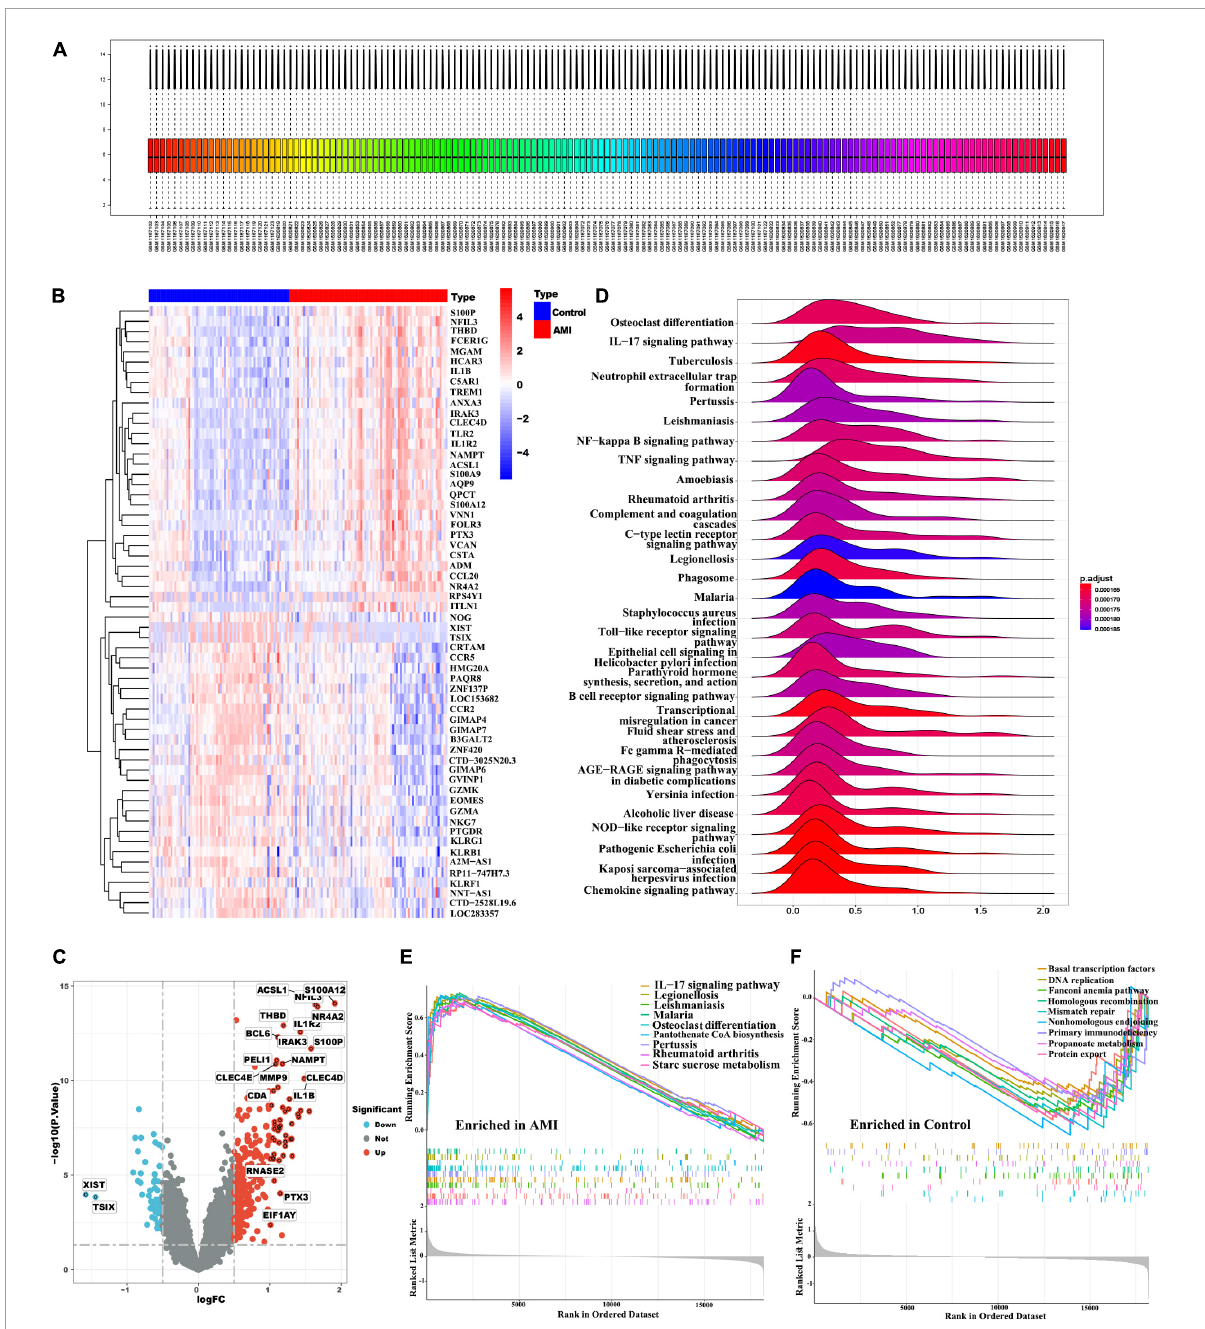
FIGURE2 Identification of DEGs and functional annotation. (A) Gene expression level statistics of the integrated dataset after removed batch effect. (B) The heatmap of AMI-related DEGs expression levels: blue-low gene expression; red-high gene expression. (C) The volcano plot of AMI-related DEGs expression. (D) Ridgeline plot of GSEA results. (E,F) The main signaling pathways that are significantly enriched in the AMI group (E) , and in the control group (F)